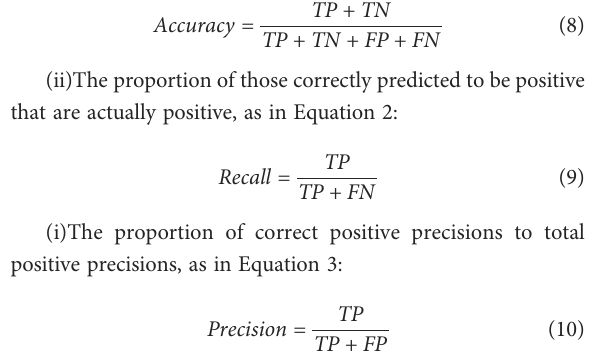
TABLE 2 Classi fi cation accuracy of the test set in different